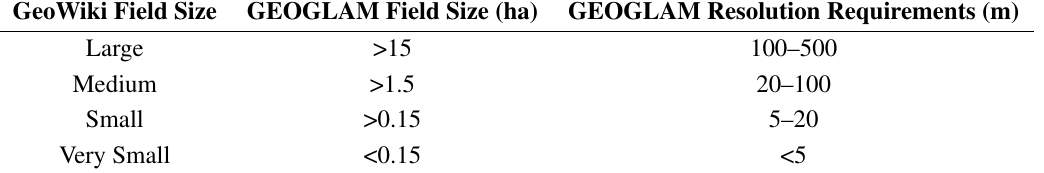
4. Linking the observed field size by crowd-sourcing to the spatial resolution